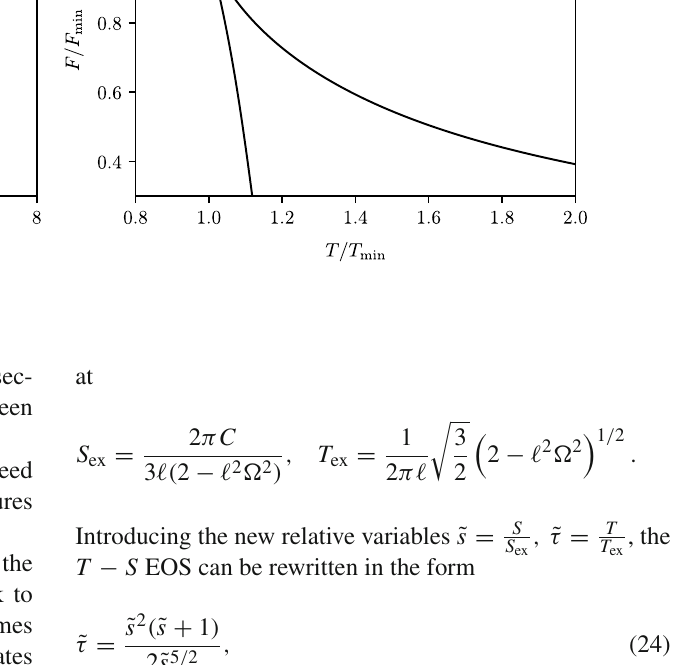
swallow tail disappears and the phase transition becomes sec- ond order. The same characteristic properties were also seen in the case of RN-AdS black hole in the RPS formalism. Notice that, in plotting the above curves, there is no need to worry about the upper bound for J , because the figures only cover a small portion of the positive T